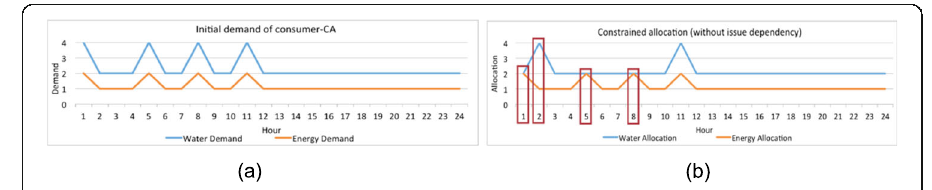
Fig. 9 Multi resource coordination without issue dependency. a Initial resource demand of consumer-CA b Results of constrained allocation without issue